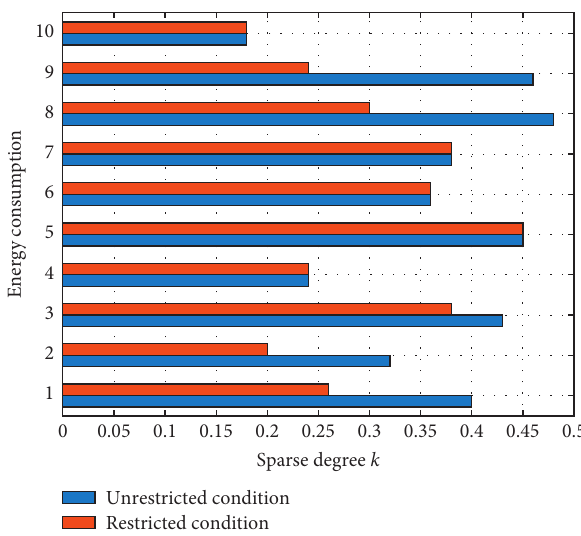
Figure 7: Energy consumption of greedy algorithm’s fast adaptive character animation synthesis.